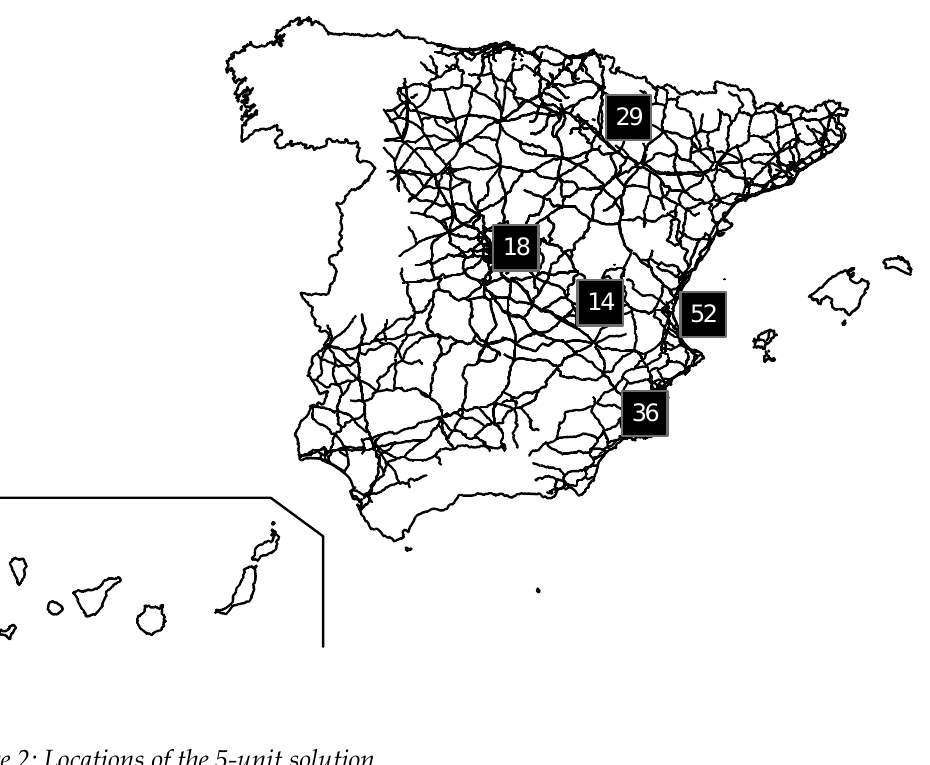
Figure 2: Locations of the 5-unit solution Table 3 reflects the aggregate values of the 66 units (service areas) considered in this solution. The 5 units selected to form the subset are marked as number 1 in bold in the corresponding column. Units 36 and 37 have the maximum aggregate value. However, only one of them is selected because they are less than 150 km apart and their joint selection would not comply with the restriction imposed on the problem. In the case of units 54 and 56, their aggregate value is very similar, but only number 54 is selected because the distance between them is again too